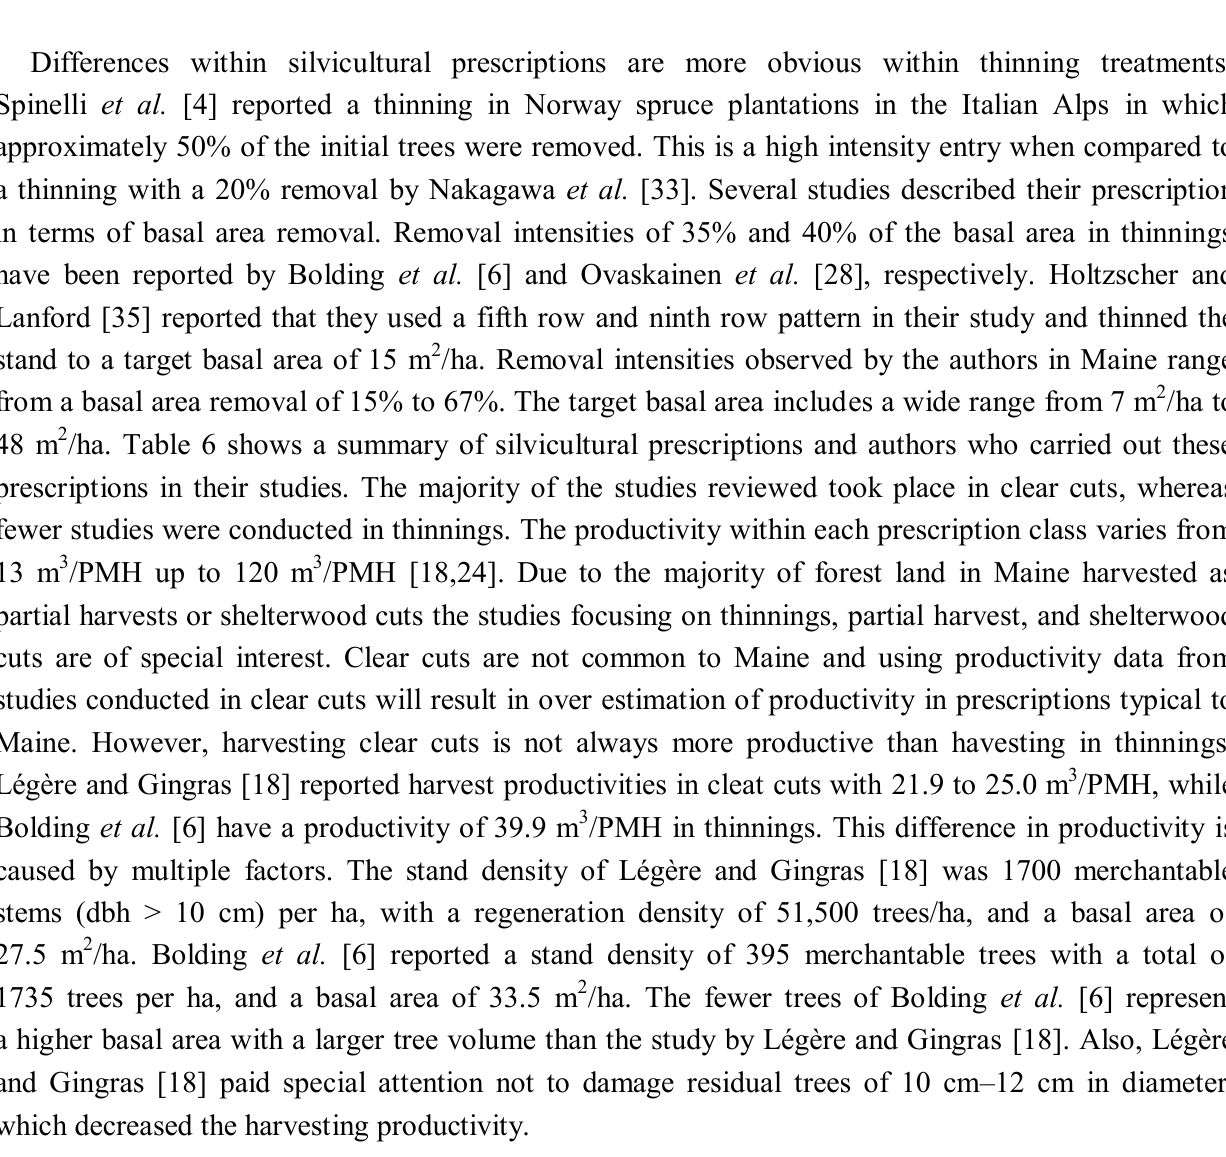
Table 6. Silvicultural prescriptions of harvesting equipment productivity